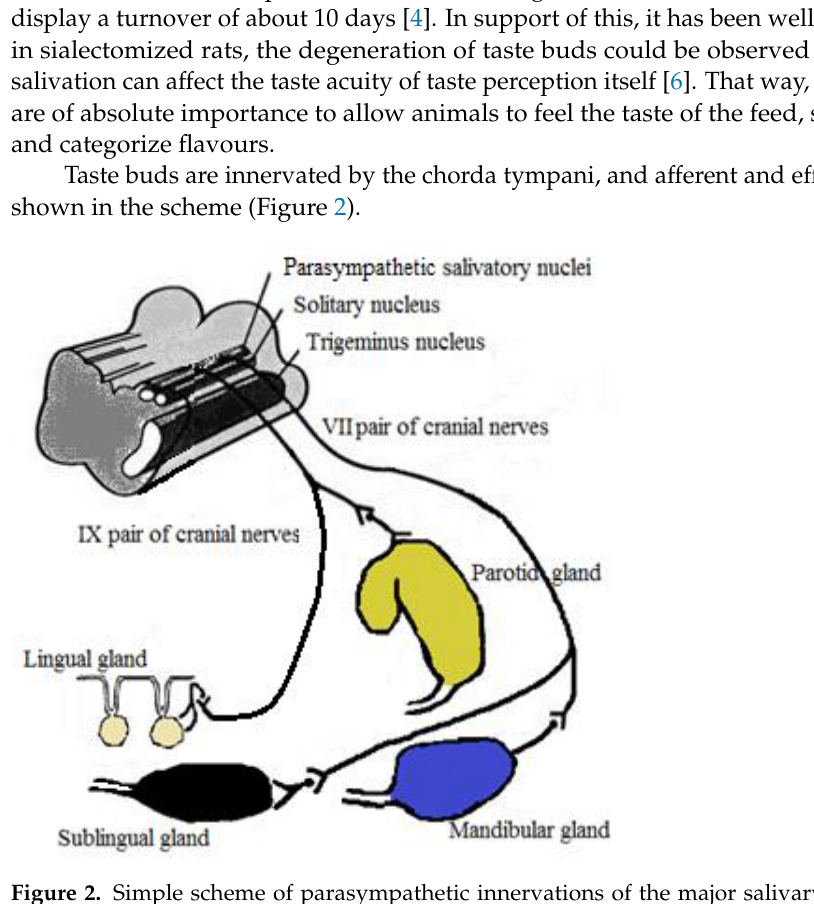
Figure 2. Simple scheme of parasympathetic innervations of the major salivary glands and von Ebner’s glands of taste buds. Interestingly, the induction of salivary secretion is carried out thanks to parasympathetic ganglia. Purely serous glands (parotid and von Ebner’s glands) are innervated by the IX pairs of cranial nerves. Mixed salivary glands (mandibular and sublingual glands) are innervated by the VII pair of cranial nerves, as shown in the figure. In the mesencephalic nuclei (solitary, parasympathetic, and trigeminus), information is centrally modulated for the response, with autonomic (unconscious, noncortical) response.